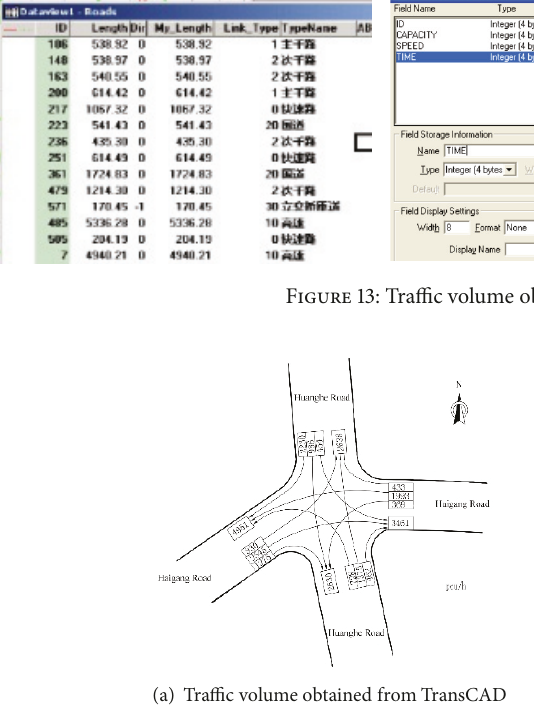
Figure 14: The microscopic traffic model in